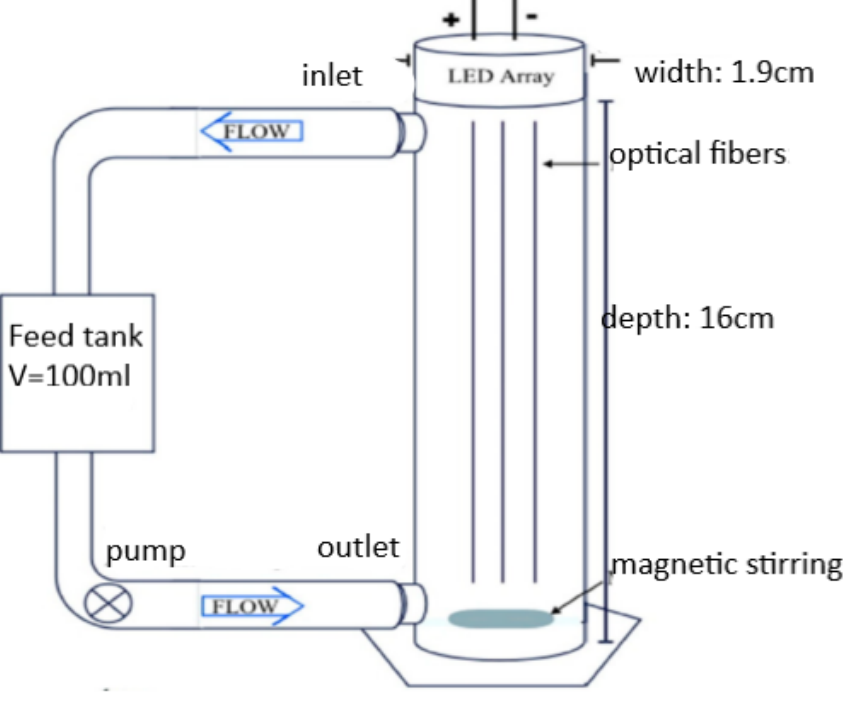
Figure 7. Schematic design of an optical fiber LED reactor developed by Tugaoen et al. Reproduced with permission from [119], Copyright 2018 Elsevier.